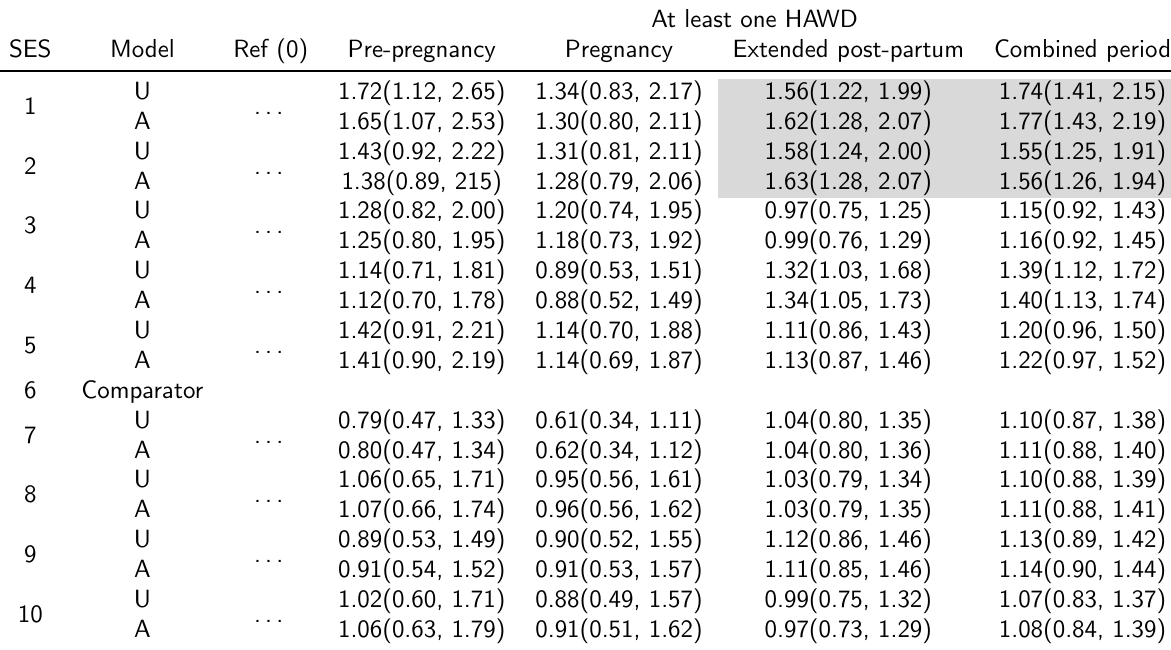
Table 3: Odds (with 95% confidence intervals) of anti-depressant use and hospitalizations (medical or psychiatric) associated with depression over SES